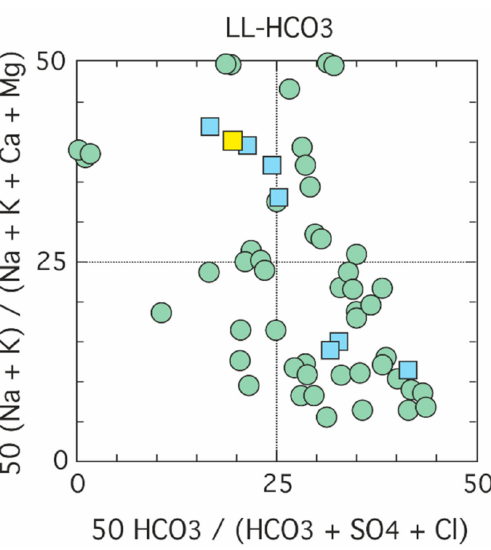
Figure 6. LL-HCO 3 diagram [59] for selected groundwater samples from Sicilia region (green dots, data after [66]; blue squares, data after [67]). The yellow square represents the chemical composition of E29 well groundwater.